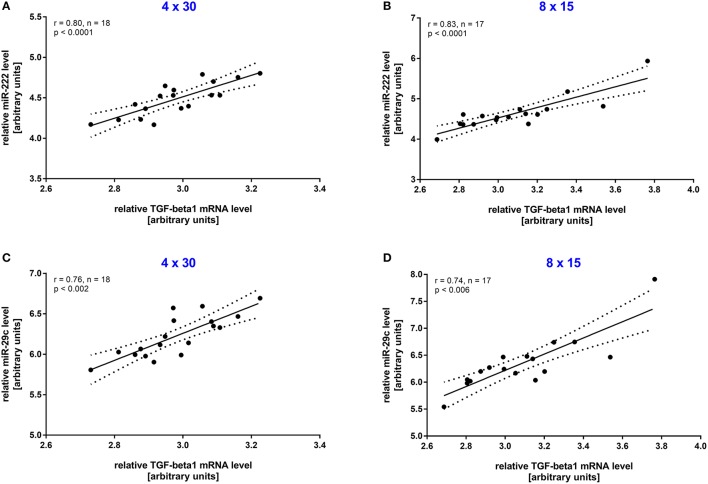
Resting miR-222 and miR-29c levels were associated with TGF-β1 mRNA levels after the intervention. After the 4-week training intervention a significant correlation in resting TGF-β1 mRNA levels and miR-222 and miR-29s levels was detected in the (A,C) 4 × 30 HIIT group as well as the (B,D) 8 × 15 HIIT group. Individual data points are shown with 95% CI and linear regression.